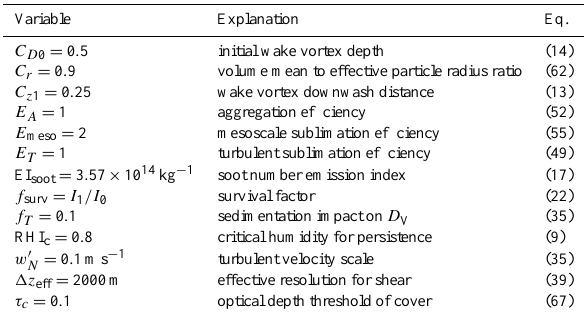
Table 2. Critical model